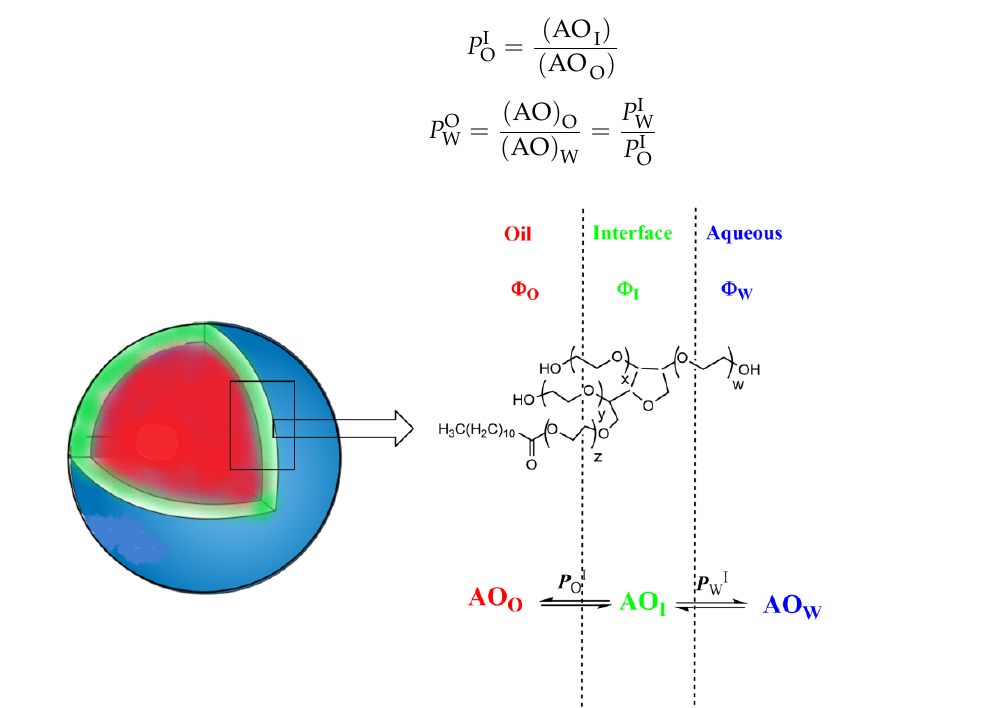
Scheme 1. Illustrative representation of an emulsion droplet (left) and the conceptual division in the oil, interfacial, and aqueous regions (right), showing the distribution of an antioxidant AO between the oil (O), interfacial (I), and aqueous (W) regions, characterized by the partition constants between the oil-interfacial, P OI , regions and those between the aqueous-interfacial, P wI , regions.